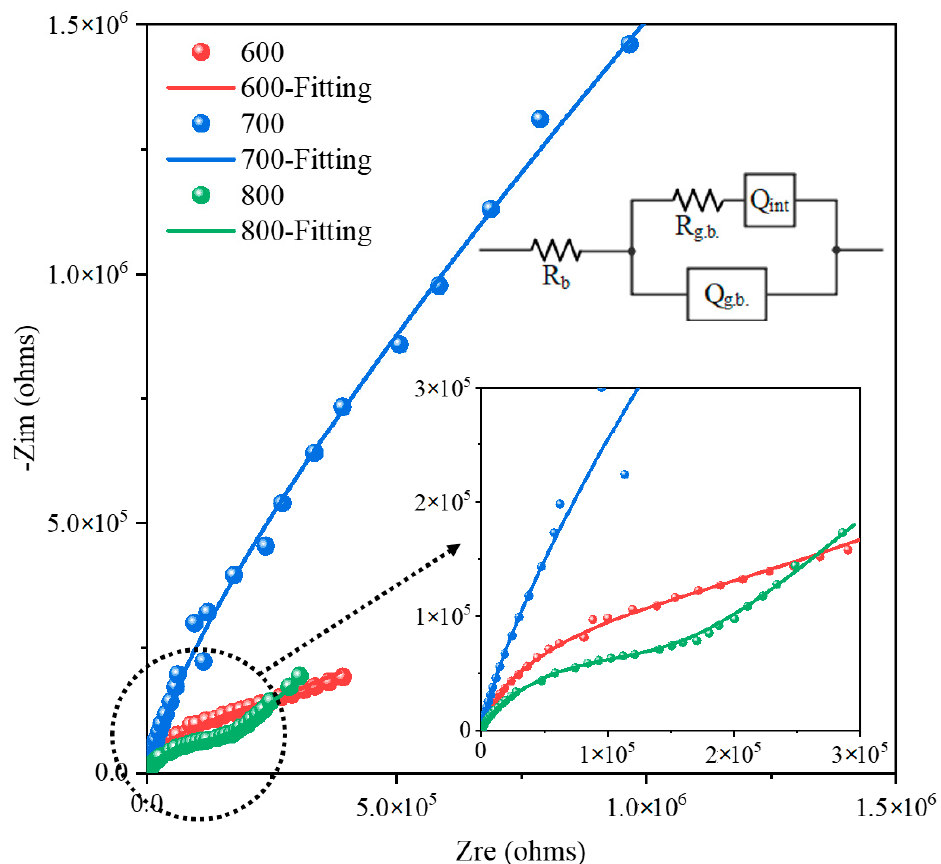
Figure 6. The Nyquist diagrams of impedance spectrum of In doped LLZO–LZO samples #800-IL (green line), #700-IL (blue line), and #600-IL (red line) measured at room temperature, insert shows the equivalent